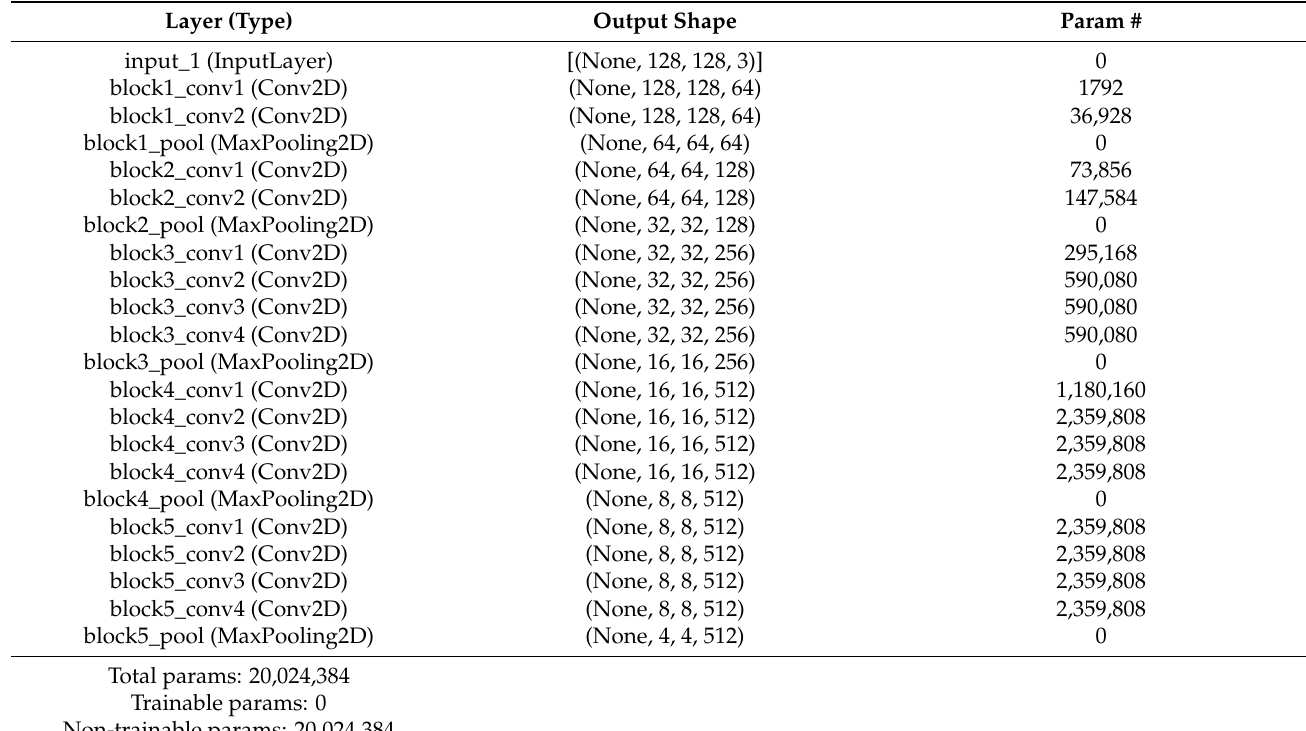
Table 6. Configuration of VGG 19 layers.